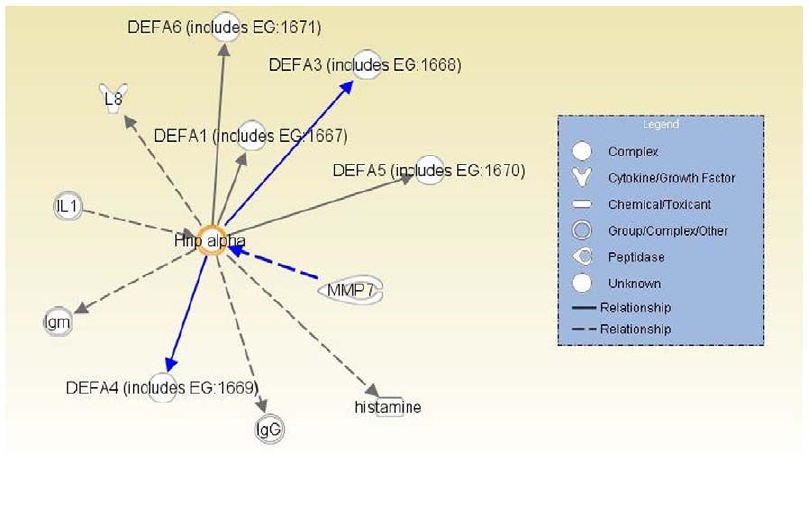
Figure 5. Alpha defensins activation pathway. Solid lines (direct relationship); Dashed lines (indirect relationship).